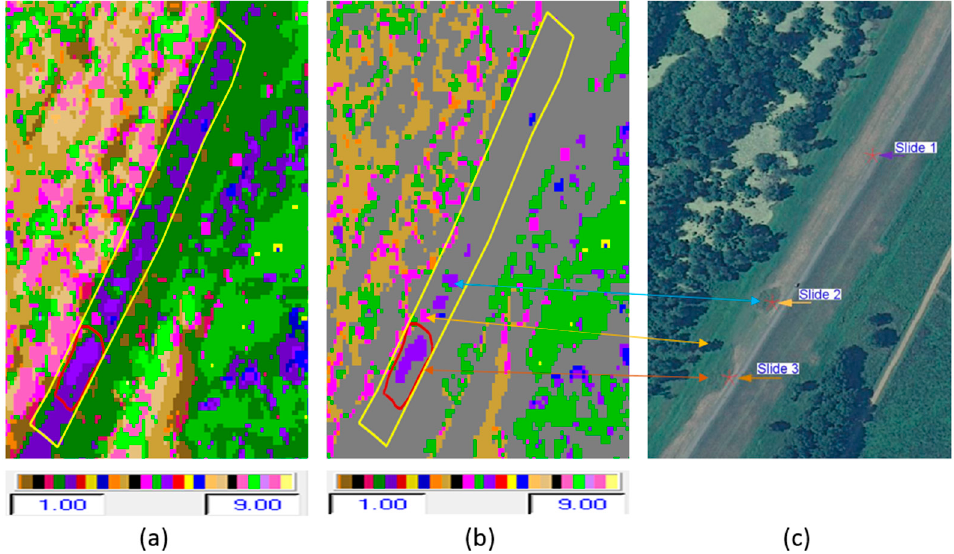
Figure 9. ( a – c ) H/ α / λ classification, H/ α / λ 2 classification, and optical image.